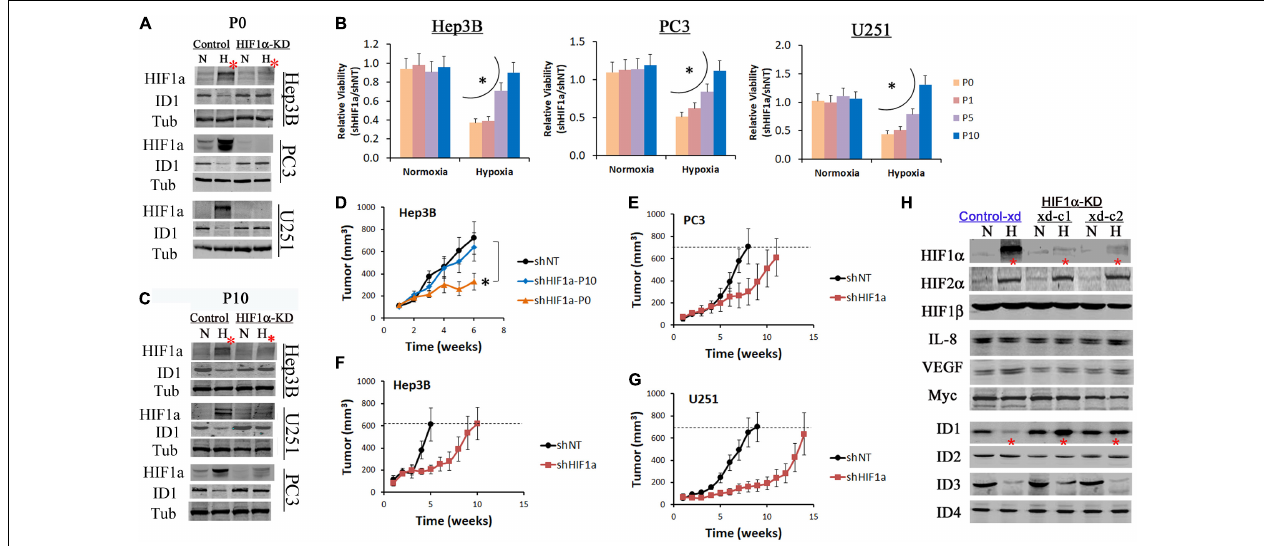
FIGURE 3 | ID1 is upregulated in tumors resistant to HIF1 α inhibition. Hep3B, PC3, U251 cells were stably transfected by lentiviral shRNA targeting HIF1 α mRNA (HIF1 α -KD) or non-specific (Control). The resulting cells were cultured in 20% O 2 (N) or 1% O 2 (H) for 24 h. (A) Western blots of HIF1 α and ID1. Tubulin was used as loading control. The P0 indicates cells did not undergo serial passages in hypoxia. (B) Control and HIF1 α -KD cells from Hep3B, PC3, and U251 underwent serial passages (1–10) in 20% or 1% O 2 . Cell viability was determined by viable cell numbers (shHIF1 α /shNT) after P0, P1, P5 and P10. ∗ P < 0.05, ANOVA, mean and stdv, n = 3. (C) Western blots of HIF1 α and ID1 after P10. (D) Control (shNT) and HIF1 α -KD cells (P0 and P10) from Hep3B were injected (3 million per injection) into the flank of male nude mice. Tumors were measured by digital caliper, ∗ P < 0.05, t -test, mean and standard error of mean (SEM), n = 8. (E–G) Control and